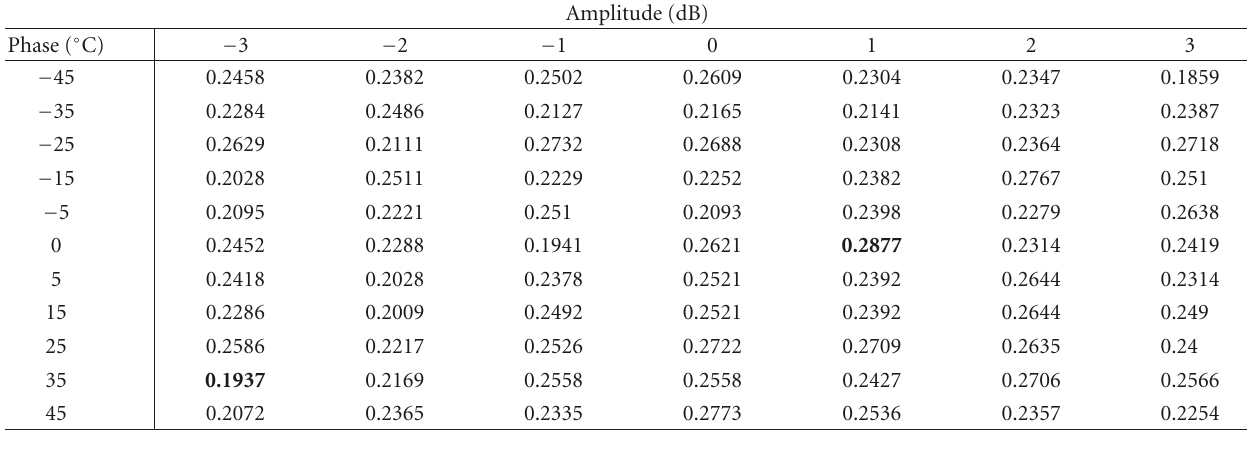
Table 1: MSE ( × 10 − 4 ) of CFO estimate with various I/Q imbalances ( ε = 0 . 2 and SNR = 20 dB). (Minimum and maximum values are highlighted.)